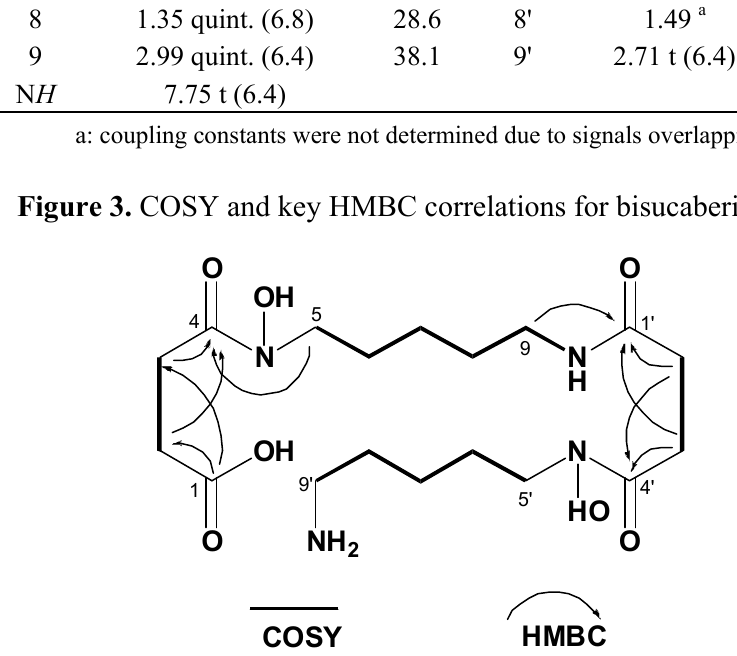
OD: DMSO- d = 1:1. 3 6